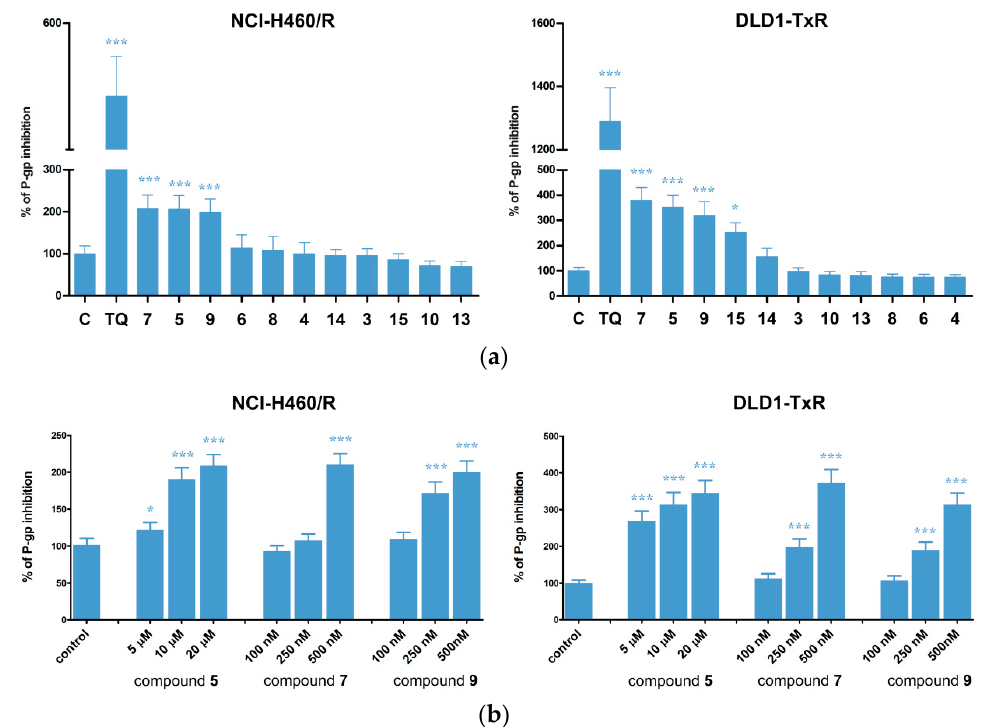
Figure 3. Suppression of P-gp activity induced by Hsp90 inhibitors. ( a ) The inhibition of P-gp activity in MDR NCI-H460/R and DLD1-TxR cells after 30 min treatment with Hsp90 inhibitors. ( b ) Dose dependent effects on P-gp inhibition in NCI-H460/R and DLD1-TxR cells after 30 min treatment with Hsp90 inhibitors. Tariquidar (TQ) is included as positive control. The results are expressed as mean ± SD. Statistical significance to untreated control from three independent experiments: p < 0.05 (*), p < 0.001